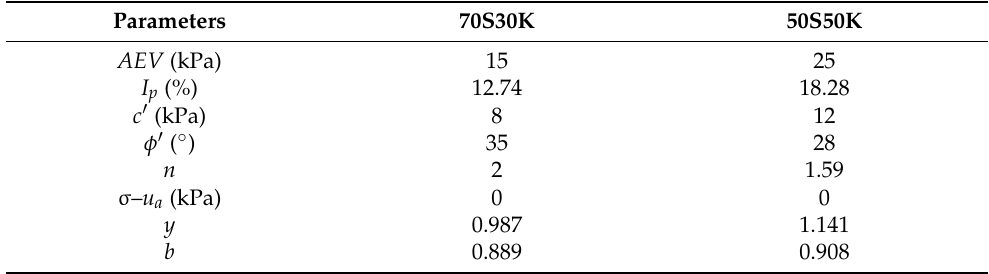
Table 6. 𝜙 b angle for different matric suctions. Table 5. Parameters of the proposed equation for predicting bimodal unsaturated shear strength in this study.